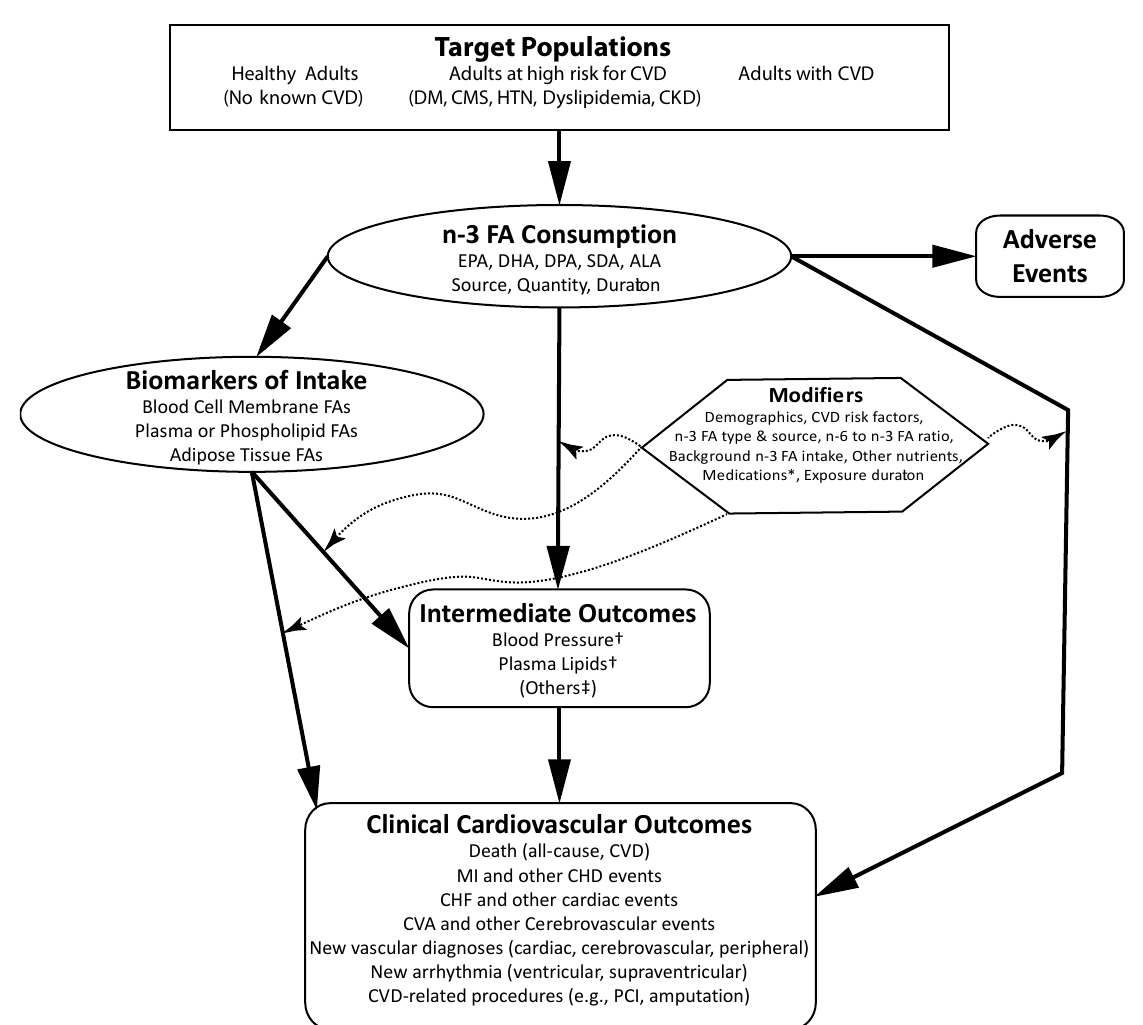
Figure 1. Analytic framework for omega-3 fatty acid exposure and cardiovascular disease. This framework concerns the effect of omega − 3 fatty acid ( n -3 FA) exposure (as a supplement or from food sources) on cardiovascular disease (CVD) events and risk factors. Populations of interest are noted in the top rectangle, exposure in the oval, outcomes in the rounded rectangles, and effect modifiers in the hexagon. * Specifically, cardiovascular medications, statins, anti-hypertensives, diabetes medications, hormone replacement regimens. † Systolic blood pressure, diastolic blood pressure, mean arterial pressure, high density lipoprotein cholesterol (HDL-c), low density lipoprotein cholesterol (LDL-c), total/HDL-C ratio, LDL-C /HDL-C ratio, triglycerides. ‡ Many other intermediate outcomes are likely in the causal pathway between n-3 FA intake and CVD outcomes, but only blood pressure and plasma lipids were included in the review. Other Abbreviations: ALA = alpha linolenic acid, CHD = coronary heart disease, CHF = congestive heart failure, CKD = non-dialysis-dependent chronic kidney disease, CMS = cardiometabolic syndrome, CVA = cerebrovascular accident (stroke), DHA = docosahexaenoic acid, DM = diabetes mellitus, DPA = docosapentaenoic acid, EPA = eicosapentaenoic acid, FA = fatty acid, HTN = hypertension, MI = myocardial infarction, n -6 = omega − 6, PCI = percutaneous coronary intervention, SDA = stearidonic